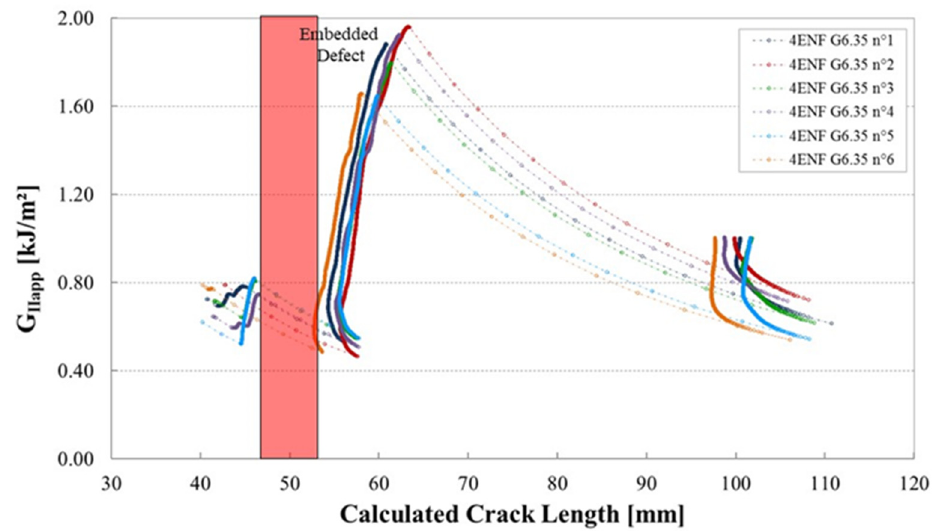
Figure 15. Mode II fracture energy as a function of the crack length for six 4 ENF specimens containing a gap of 6.35 mm from plates manufactured with caul plate.